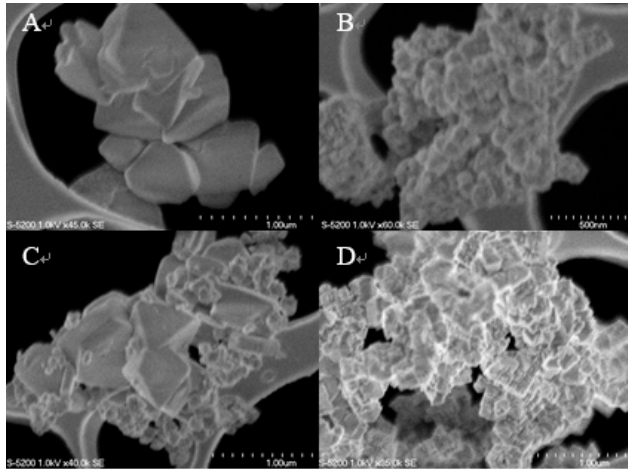
Figure 2. FE-SEM images of ( A ) MnH-Y, ( B ) MnH-Beta, ( C ) MnH-ZZm-0.5 and ( D ) MnH-ZZs-0.5.